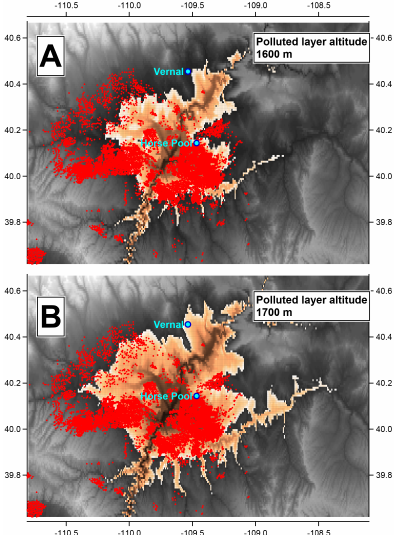
Figure 6. Topographical map of the Uintah Basin showing polluted region and well locations. Total relief is from 1398m above sea level to 3627m. The bright (tan) region shows the area of the pol- luted region assuming the polluted layer extends to 1600m (a) or 1700m above sea level (b) . Locations of producing oil and gas wells are marked in